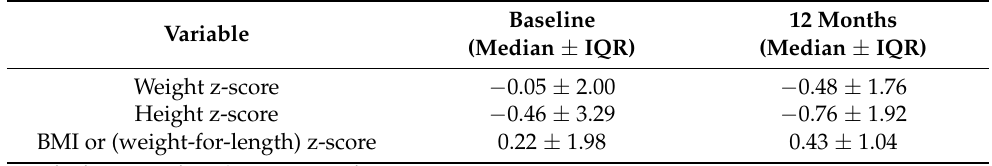
Table 4. Change in growth of study patients after 12 months on cKD (data collected only in 6 patients, because of drop-out rate).